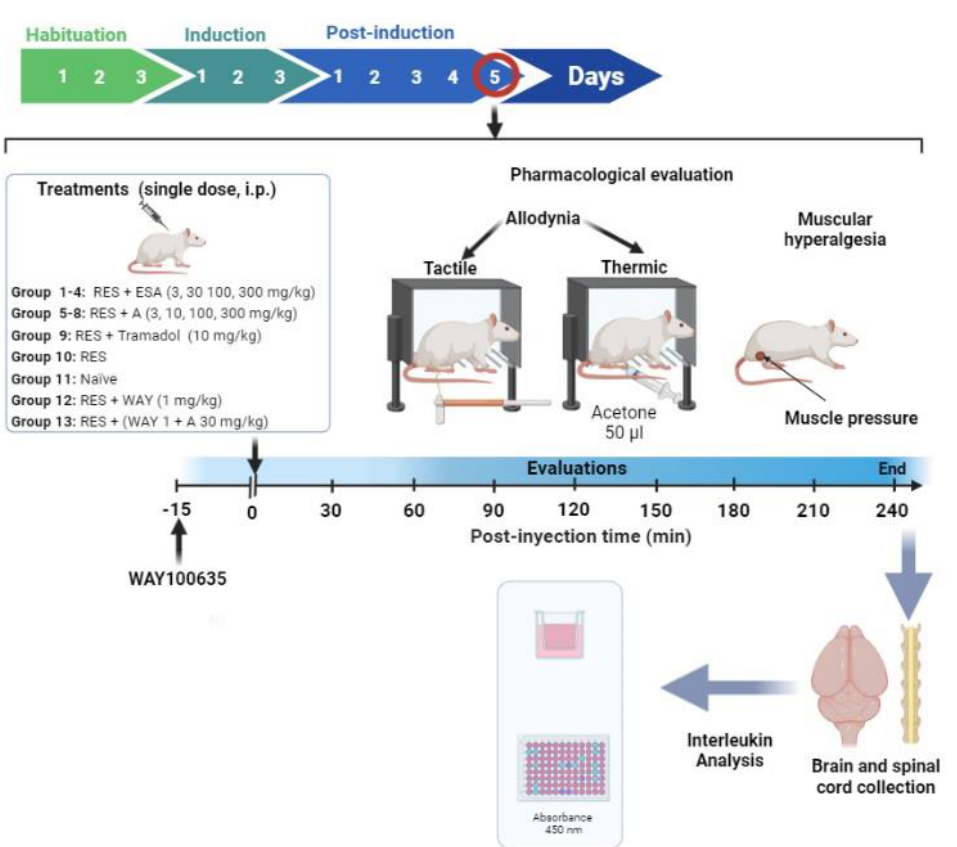
Figure 1. Timeline of the experimental design assessing the EtOAc extract of Salvia amarissima (ESA) and amarisolide A in the experimental FM-type pain induced by reserpine (RES).